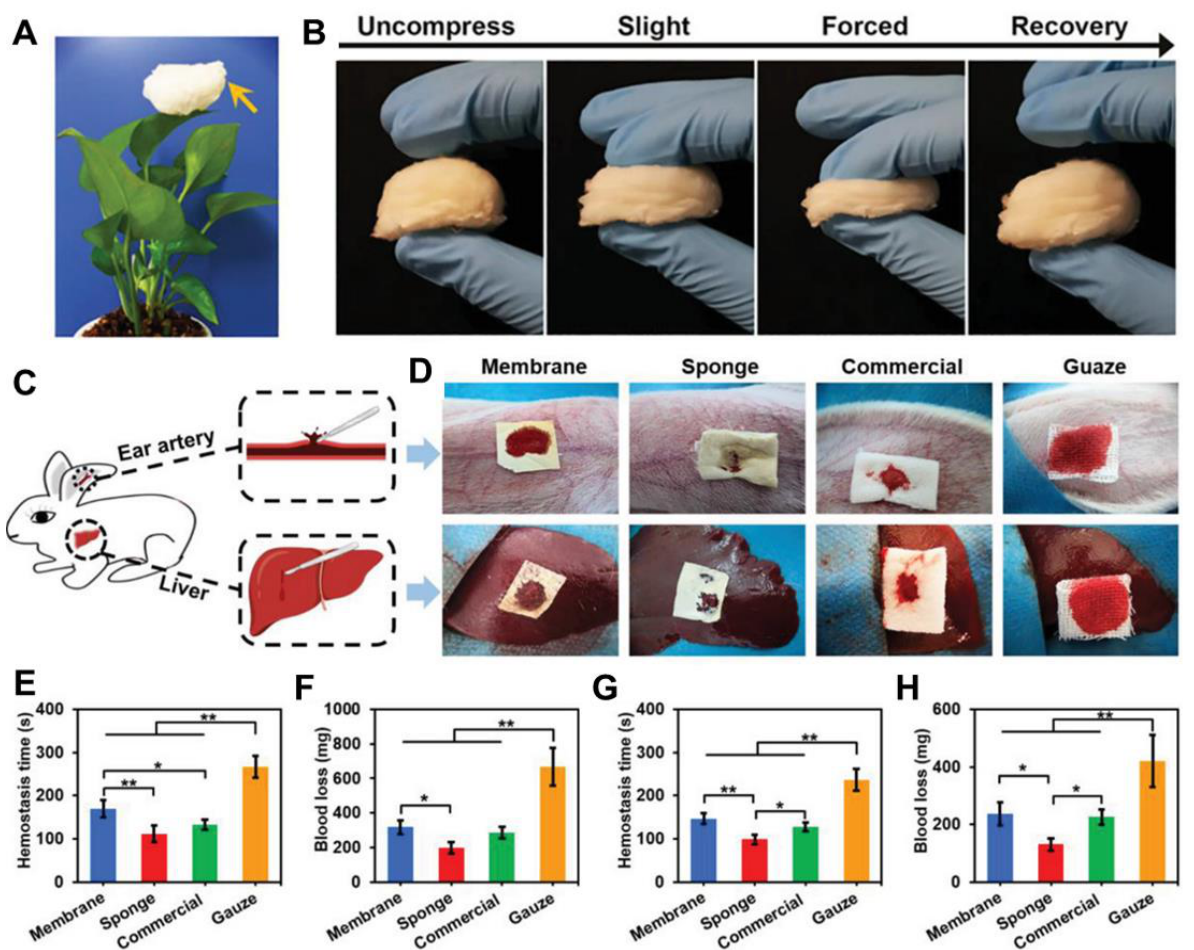
Figure 6. Design and development of a novel 3D electrospun gelatin nanofiber sponge as rapid hemostasis materials. ( A ) Photograph of the as-prepared 3D electrospun gelatin nanofiber sponge standing on a leaf. ( B ) Photographs of compress and recovery of gelatin nanofiber sponge with different degrees of external forces. ( C ) Schematic of an in vivo liver trauma model and an ear artery injury model using rabbit. ( D ) Photographs of hemostasis based on the two different injury models using four different samples. Membrane: electrospun 2D gelatin nanofiber mat; Sponge: 3D electrospun gelatin nanofiber sponge; Commercial: commercial 3D gelatin nonfibrous hemostatic sponge; Gauze: Commonly used medical gauze. ( E ) hemostasis time and ( F ) Blood loss of four different material groups based on the ear artery injury model. ( G ) hemostasis time and ( H ) Blood loss of four different material groups based on the liver trauma model. * p < 0.05, ** p < 0.01. Reprinted with permission from ref. [132], Wiley, 2021.